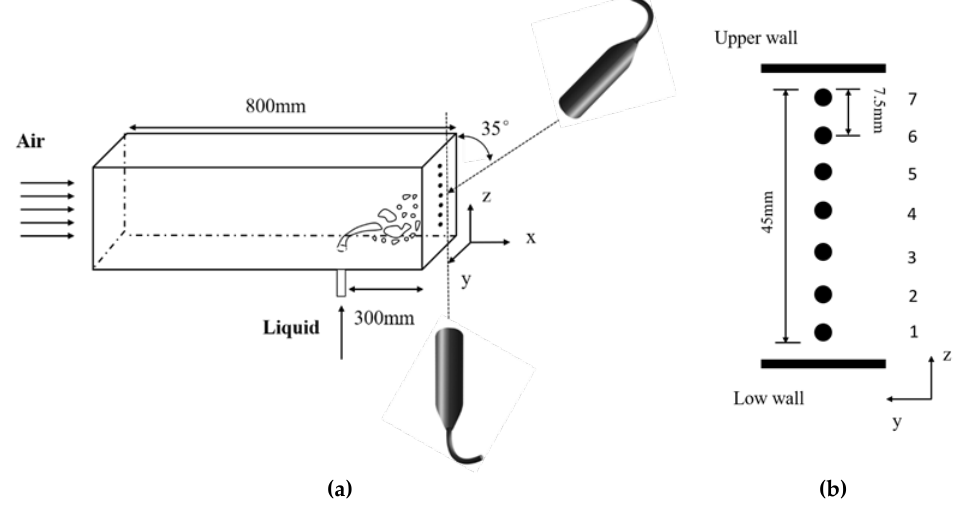
Figure 4. Schematic of test section, ( a ) is PDA test system and ( b ) is distribution of measuring points.